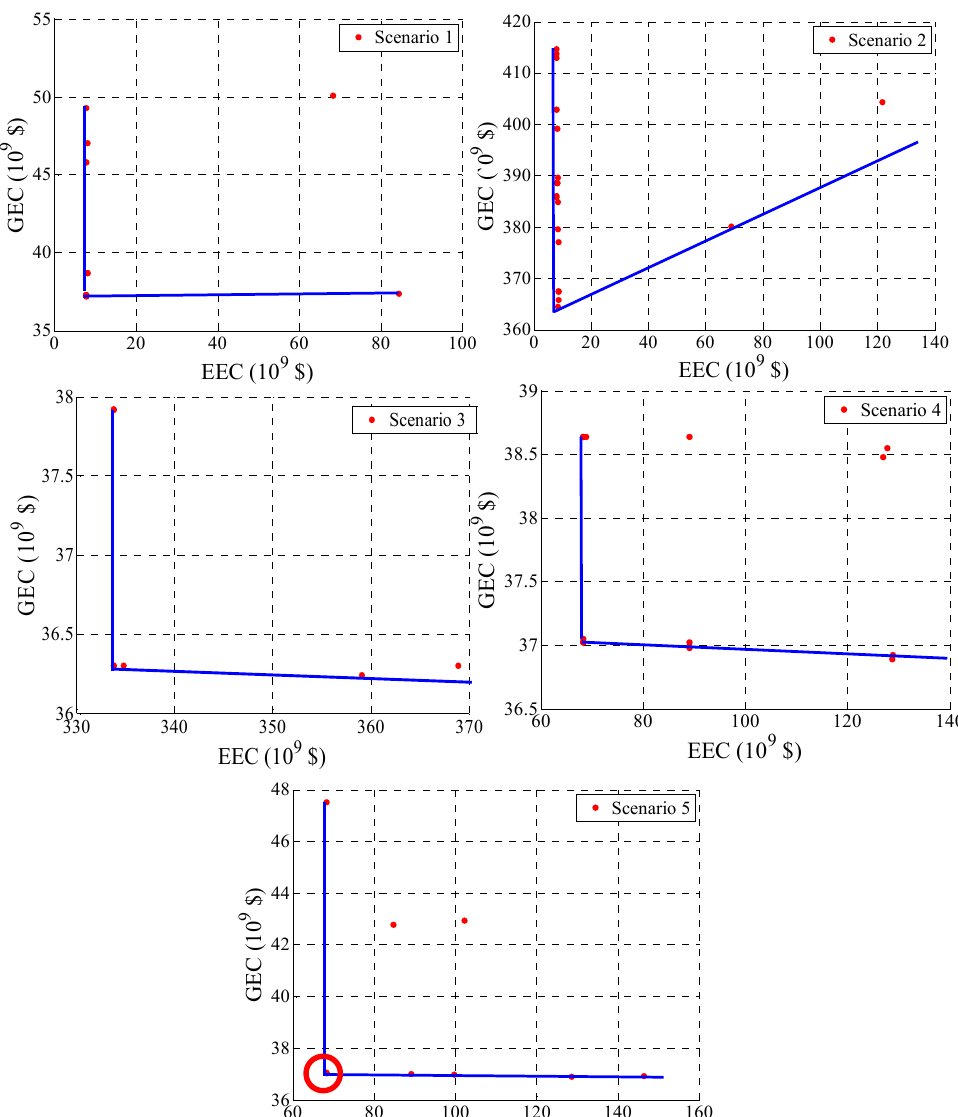
Figure 9. Impact of different investment budget scenarios on Pareto optimal results.